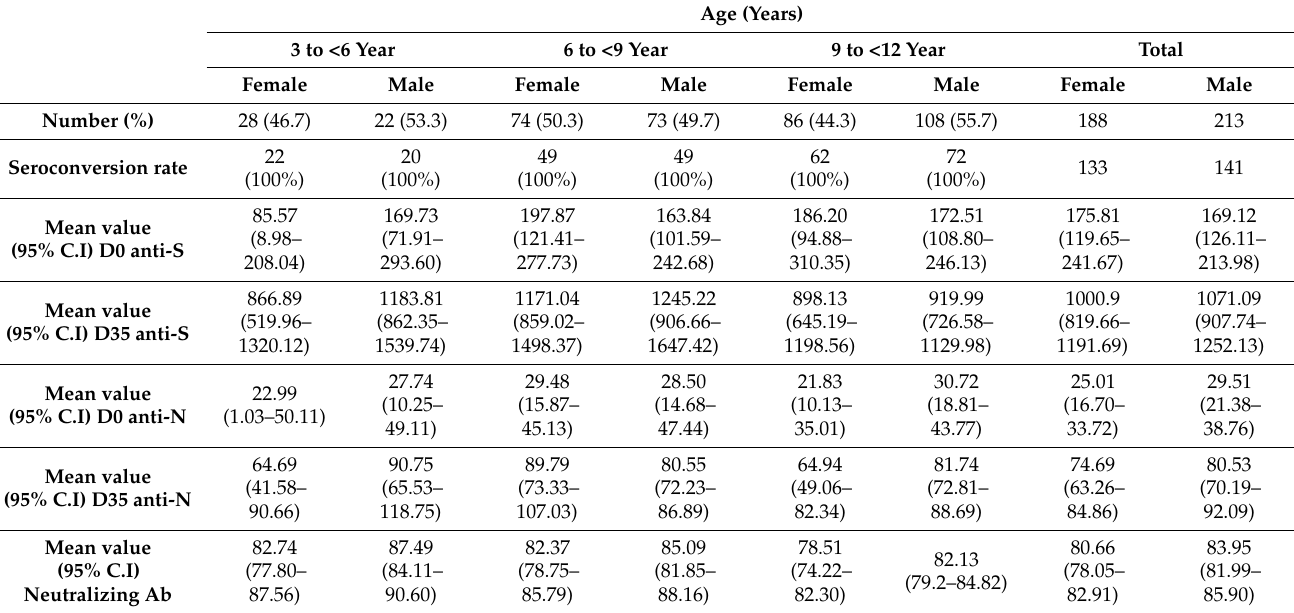
Table 5. Antibody response in males and females in different age groups.